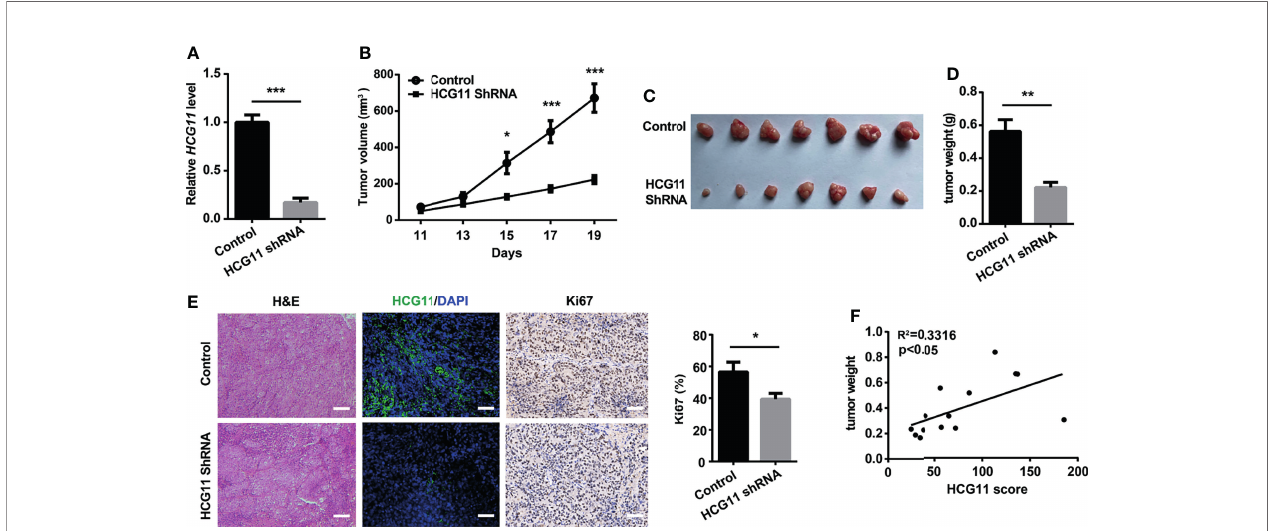
FIGURE 4 | HCG11 knockdown inhibited NPC tumor progression in nude mice. Control or HCG11shRNA-transfected 5-8F cells (A) were inoculated into the backs of nude mice. (B – D) Tumor growth curve (B) , tumor graph (C) , and tumor weight (D) in HCG11-shRNA and control 5-8F tumors are shown. (E) H&E, HCG11, and Ki67 staining are shown in 5-8F tumors. Scale bar, 50 m m. (F) Correlation analysis of HCG11 levels and tumor weight in 5-8F tumors. Data are presented as mean ± SEM. *p < 0.05, **p < 0.01, ***p < 0.001. n = 7 mice per group.